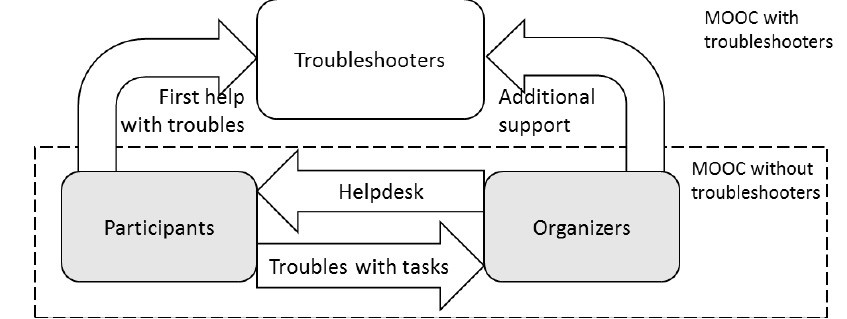
Figure 1 . The research